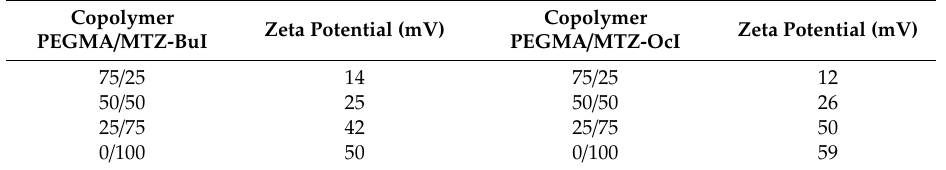
Table 2. Zeta potential values of the cationic copolymers P(PEGMA– co –MTZ-BuI) and P(PEGMA– co –MTZ-OcI).